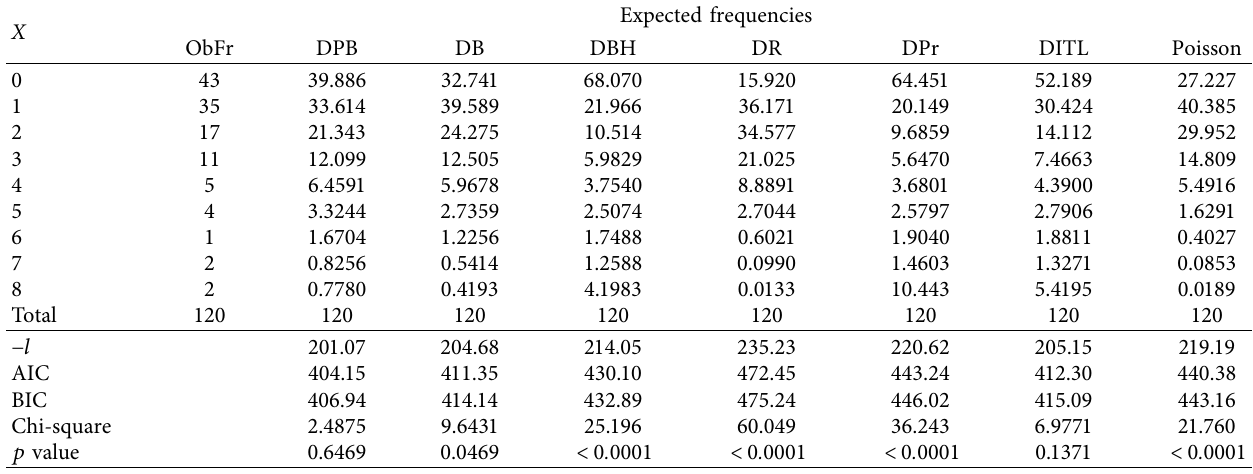
Table 9: Te GOF measures for data set I.